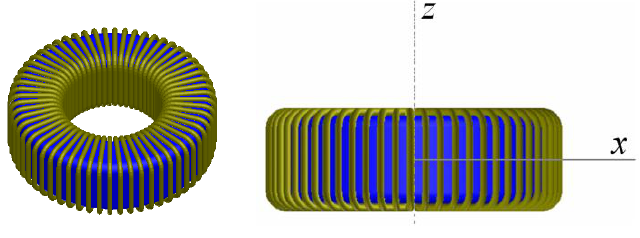
Figure 3. Geometry used for the simulations of the TN23/14/7 toroid with rounded corners and 60 turns.